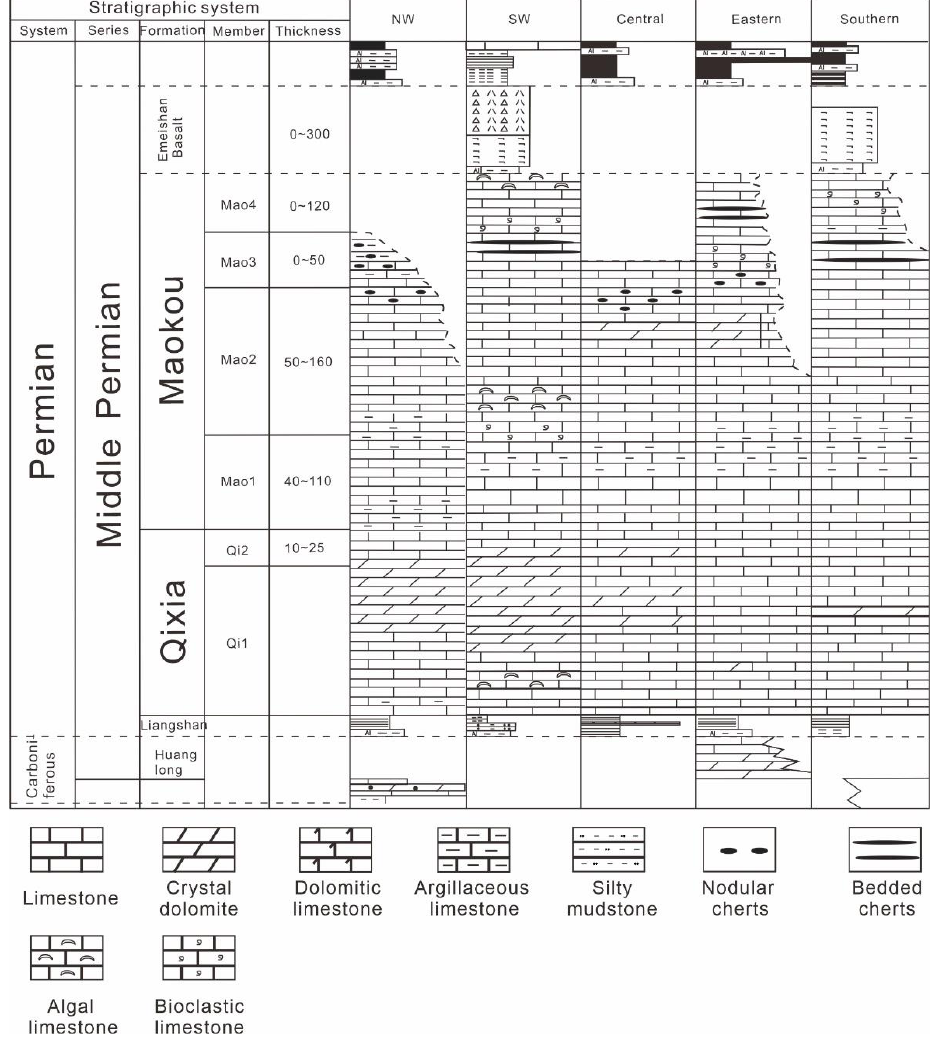
Figure 2. The comprehensive stratigraphic column of the Middle Permian in the Sichuan Basin (modified from [38] ).